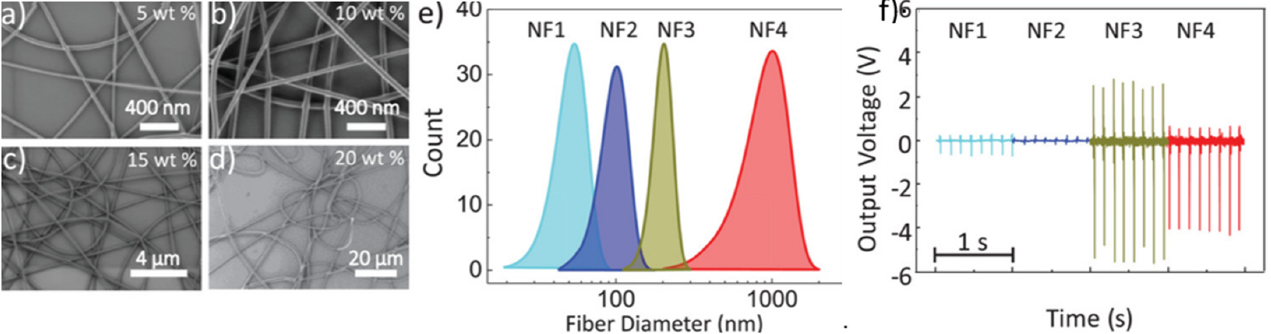
Figure 4. Examples of recent developments toward piezoelectric energy harvesting materials and structures for textile application: ( a – d ) SEM images of piezoelectric electrospun PVDF fibers of different diameters ( e ) exhibiting different open circuit output voltages ( f ) (reproduced from [73], available through the Creative Commons license (creativecom- mons.org/licenses/by/4.0/)).